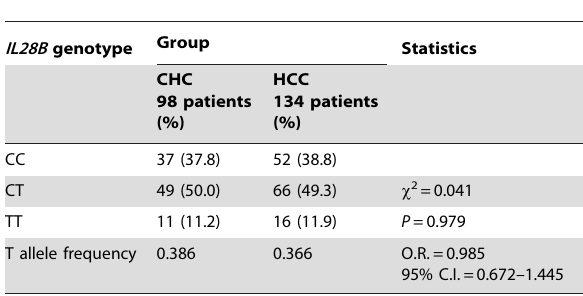
Table 3. Distribution of the IL28B gene rs12979860 genotype in untreated patients with chronic hepatitis C (CHC) and in patients with HCV-related hepatocellular carcinoma